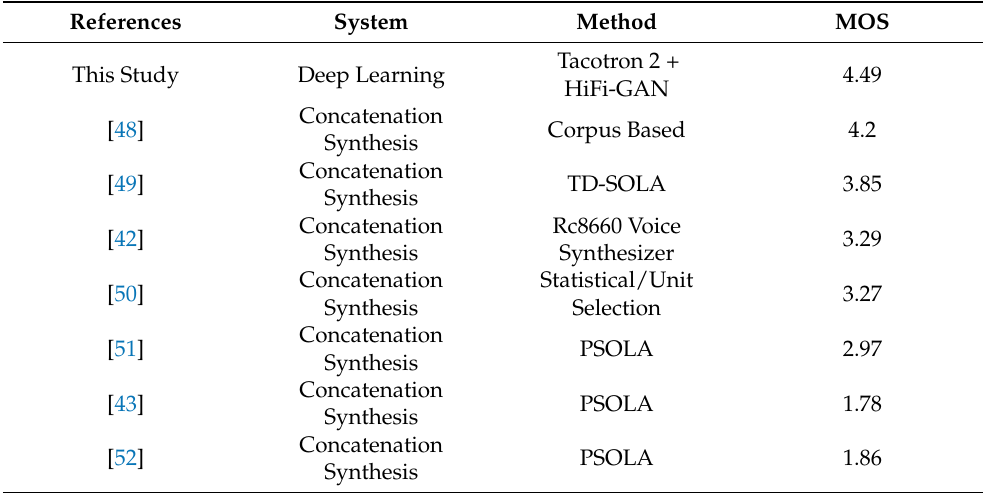
Table 8. MOS comparisons between Synthesized Speech and previous TTS systems.